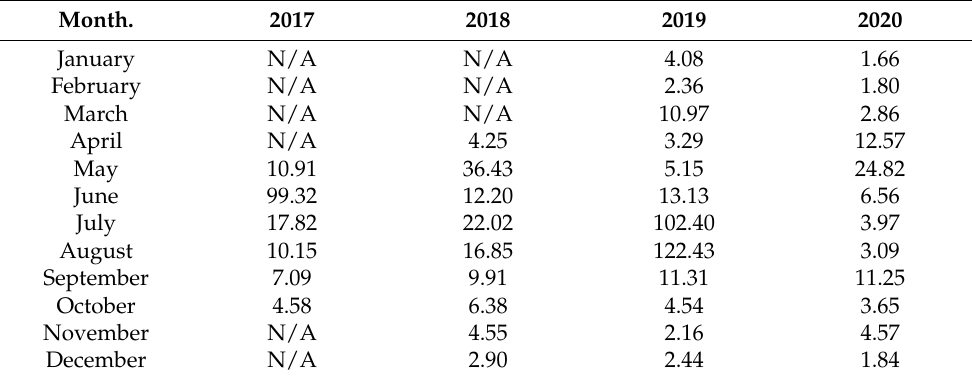
Table 7. Monthly average of weekly TP AD (mg/m 2 /week) 1